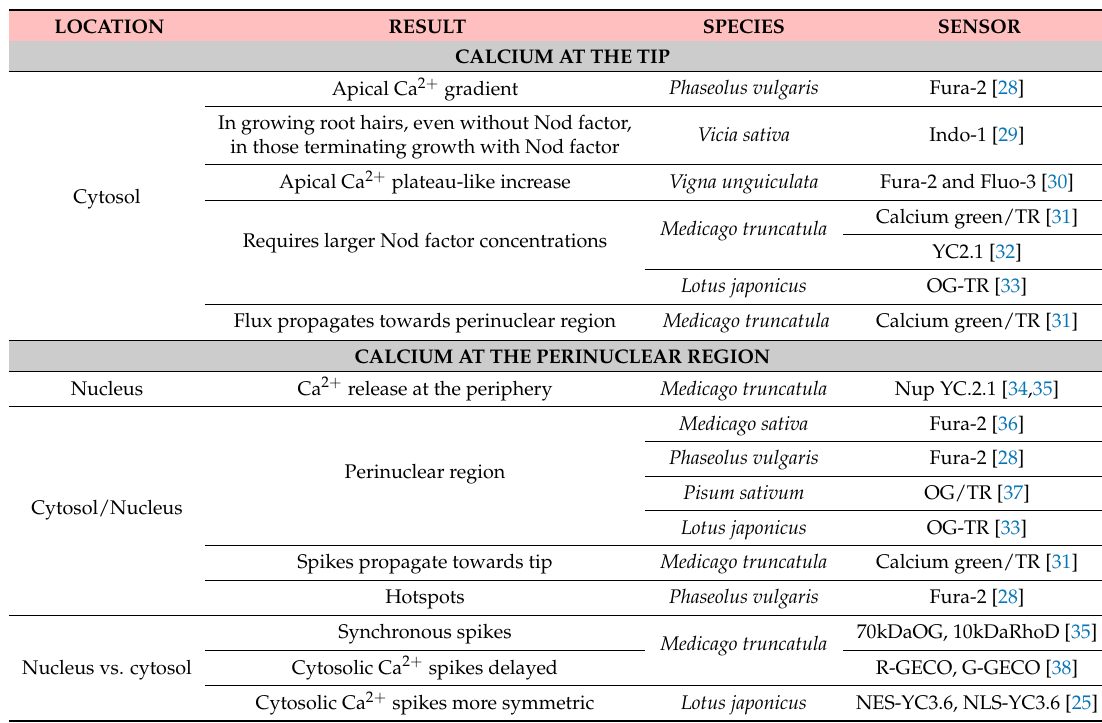
Table 1. Two different Ca 2 + signals induced by Nod factors were detected in several model legumes, with different Ca 2 +